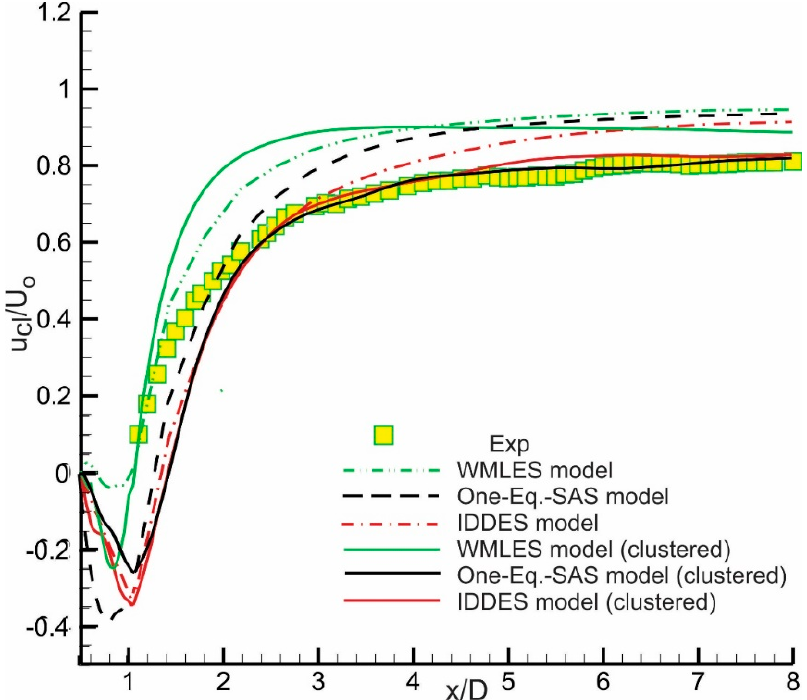
Figure 12. Centerline mean streamwise velocity distribution showing the effect of coarse and clustered mesh on the predicted profile for the One-Equation SAS, WMLES, and IDDES models.